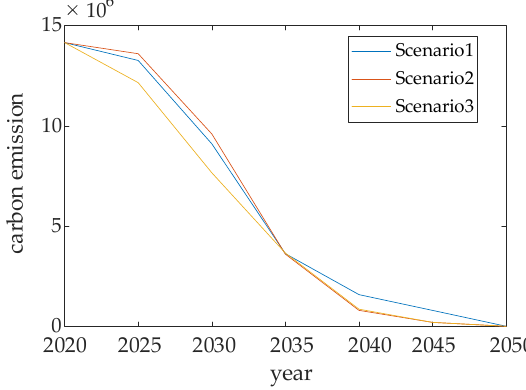
Figure 13. The results of carbon emission reduction.